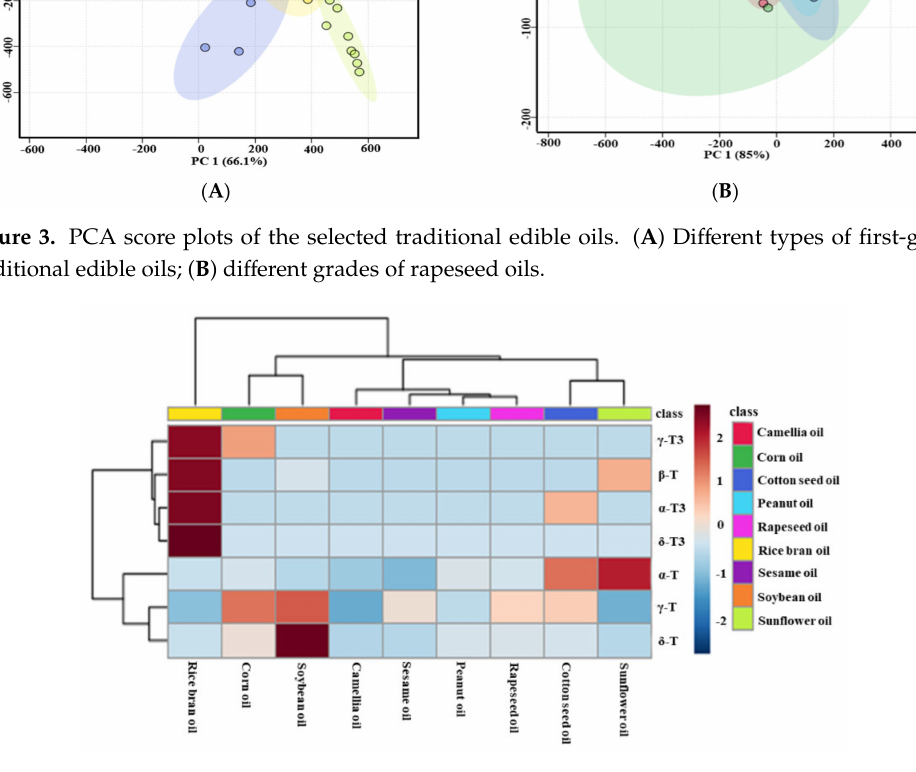
Figure 4. Heatmap explains the di ff erent contents of tocopherols and tocotrienols in the first-grade traditional edible oils (red indicates tocols distributed at a high concentration and blue indicates tocols distributed at a low